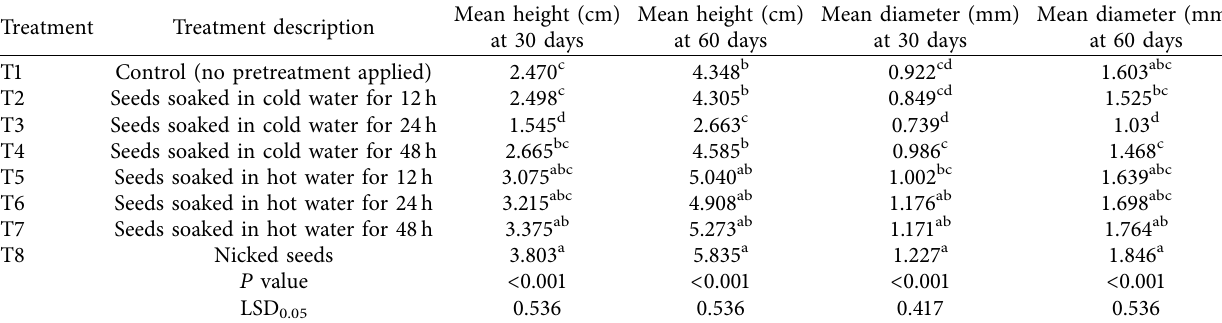
Table 3: Effect of the pretreatment methods on seedling mean height and diameter growth (cm) at 30 and 60 days after seed sowing. Treatment Treatment